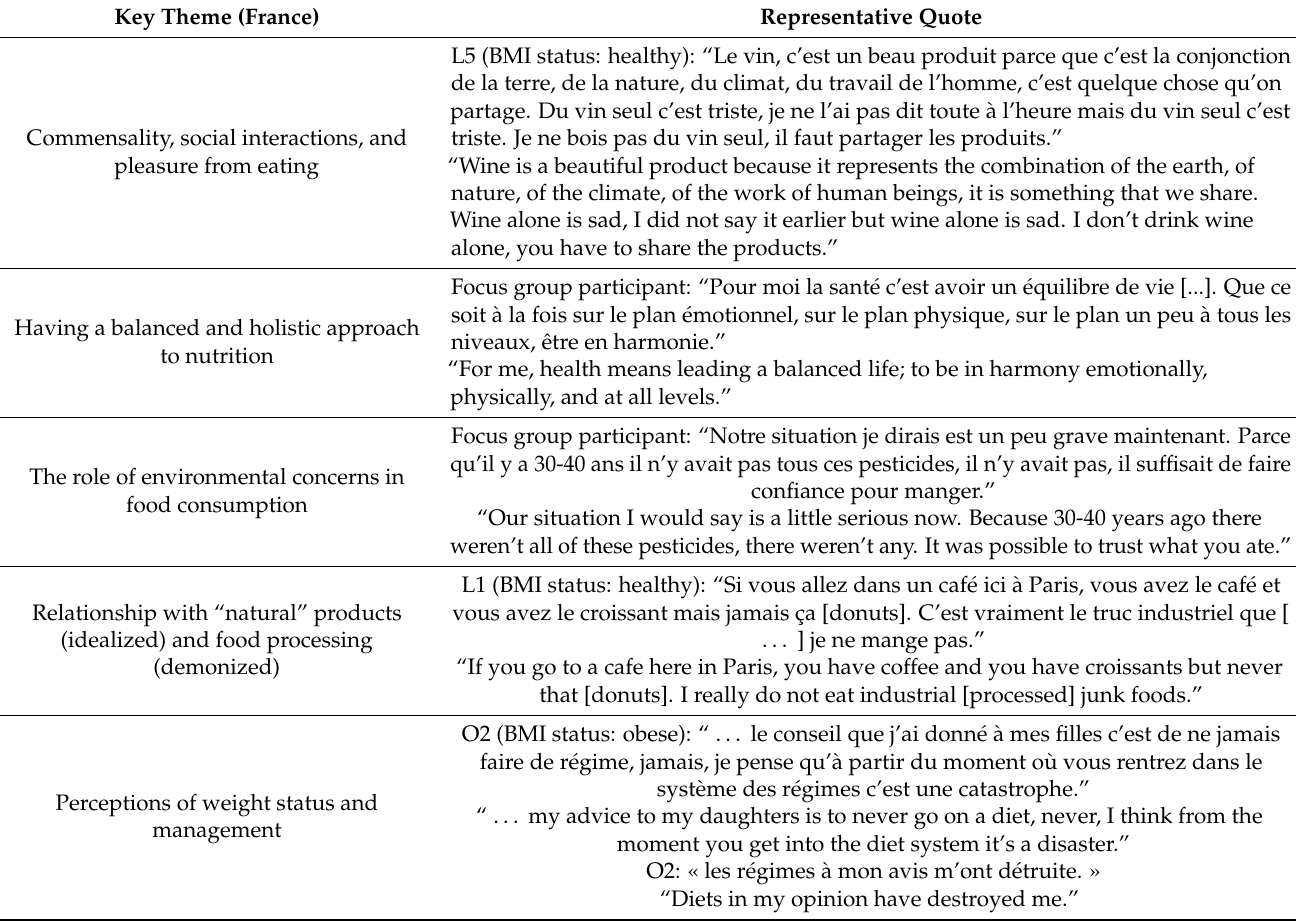
Table 3. Key themes emerging from interviews and focus groups in